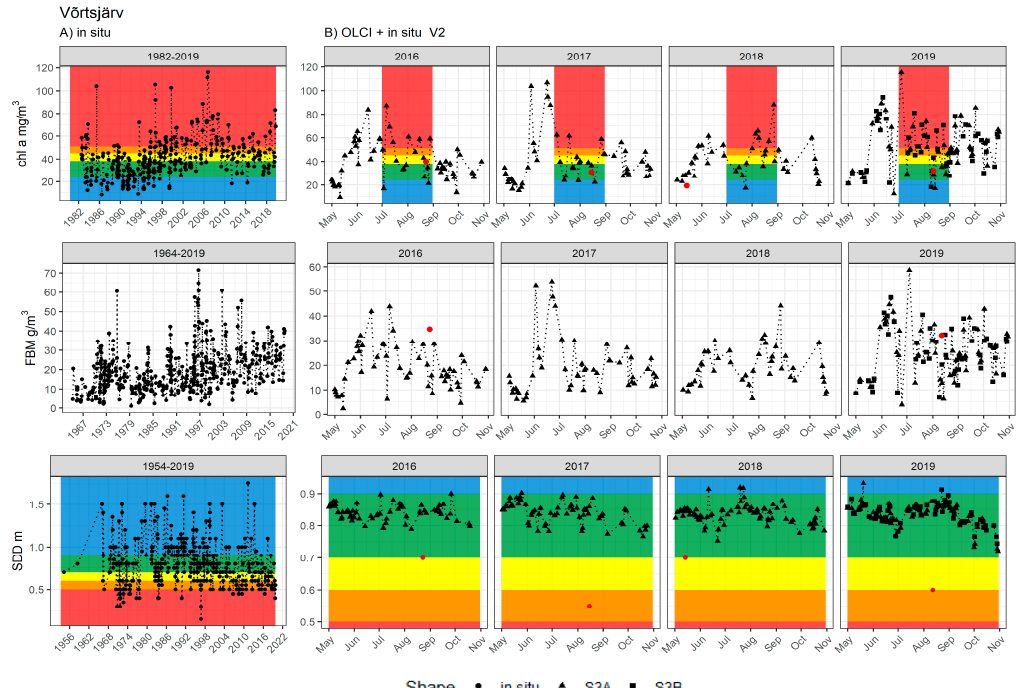
Figure 4. Long-term time series of in situ measured chl a, FBM, and SDD in Võrtsjärv in station named as V2 ( A ) and the same parameters measured from S3 Ocean and Land Color Instrument (OLCI) ( B ). Dots indicate in situ measured values. Triangles and squares indicate S3A and S3B values, respectively. Different colors represent ecological status classes according to European Union (EU) WFD, while FBM is not considered as important parameter to assess the ecological status in Võrtsjärv according to the WFD.